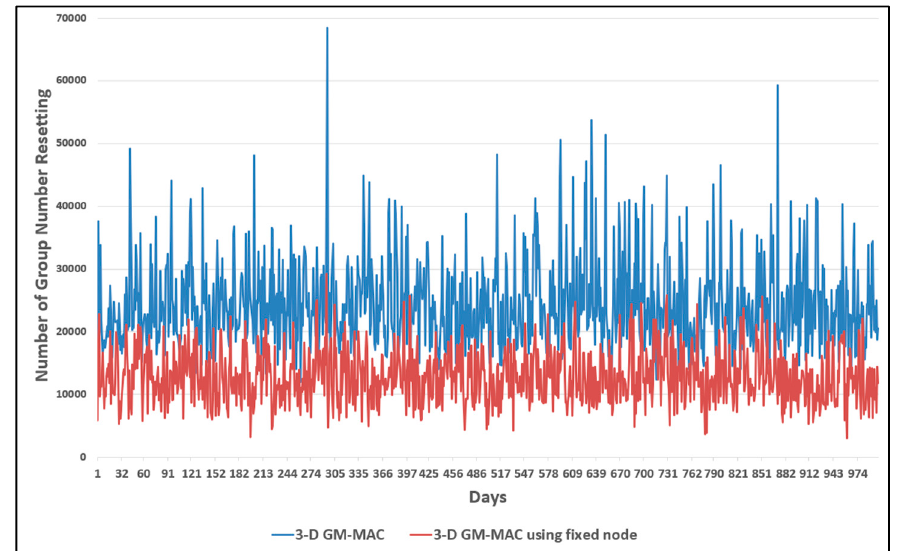
Figure 19. Comparison of node group number resets.